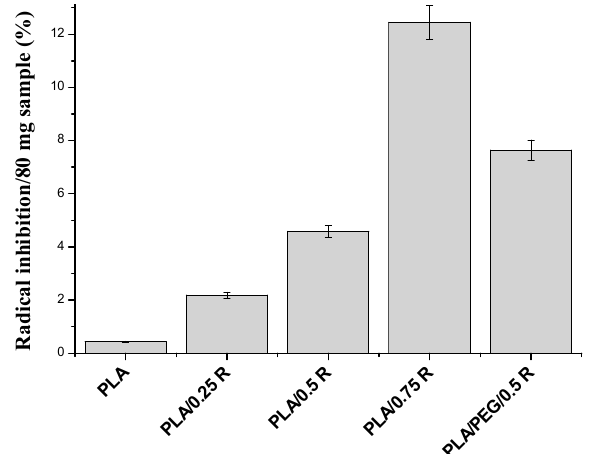
Figure 15. ABTS • + radical inhibition activity of the polymeric blends containing powdered rosemary ethanolic extract.